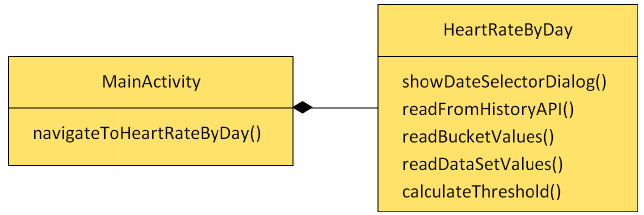
Figure 5. Diagram of